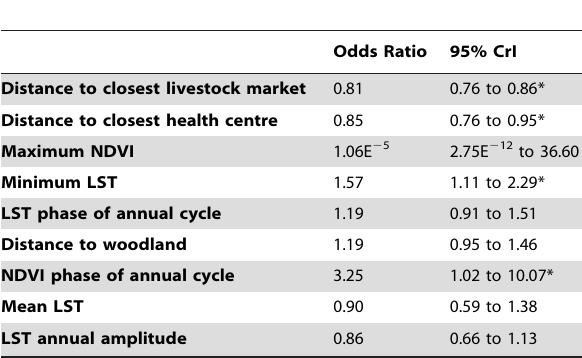
Table 1. Odds ratios and 95% CrI from Bayesian univariate regression